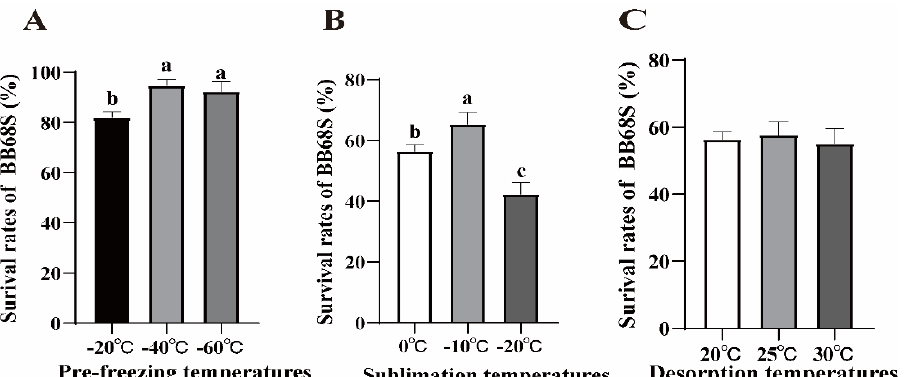
Figure 1. Influence of different temperatures during the freeze-drying process on the survival rate of Bifidobacterium longum BB68S. ( A ) Pre-freezing survival rates of BB68S under different pre- freezing temperatures; ( B ) Sublimation drying survival rates of BB68S under different sublimation temperatures; ( C ) Desorption drying survival rates of BB68S under different desorption temperatures. Different letters indicate significant differences ( p < 0.05).